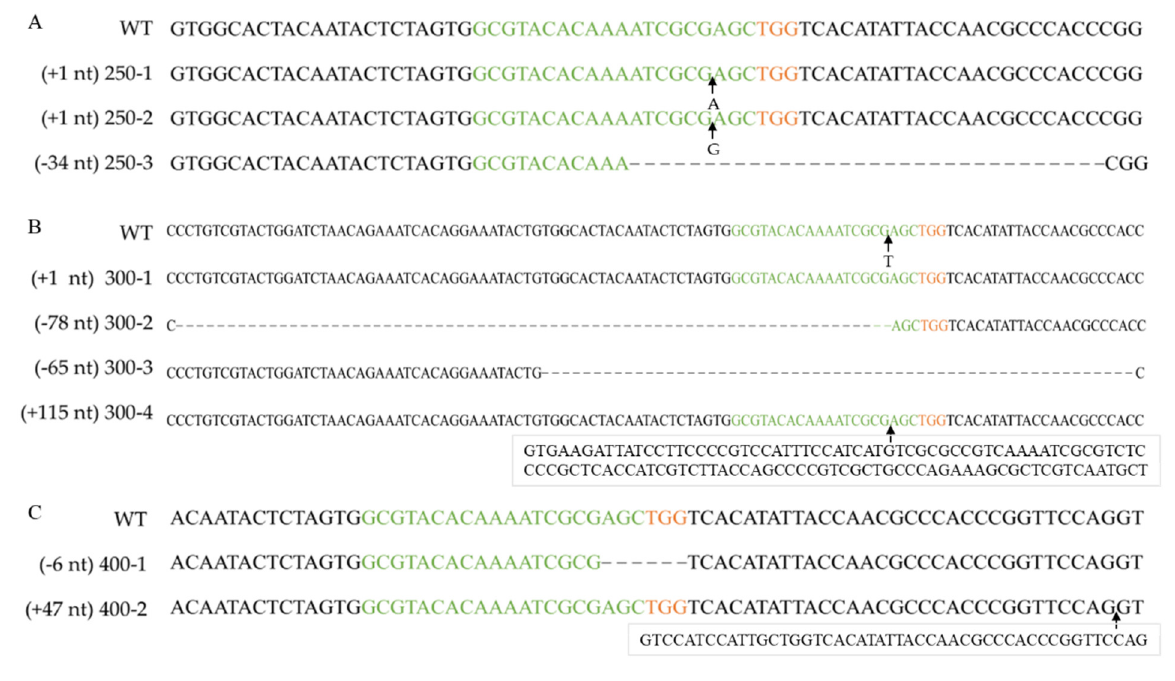
Figure 4. Verifying pyrG mutation after RNP-based gene disruption using different RNP concentra- tions. Alignment of pyrG sequences and corresponding mutants obtained by transformation with 250 nM RNPs ( A ), 300 nM RNPs ( B ) or 400 nM RNPs ( C ). WT: wild-type strain Dan3. Concentrations 250-1~250-3, 300-1~300-4, 400-1~400-2: mutants generated by transformation of RNPs. Green marked represents spacer sequences; orange marked represents PAM.